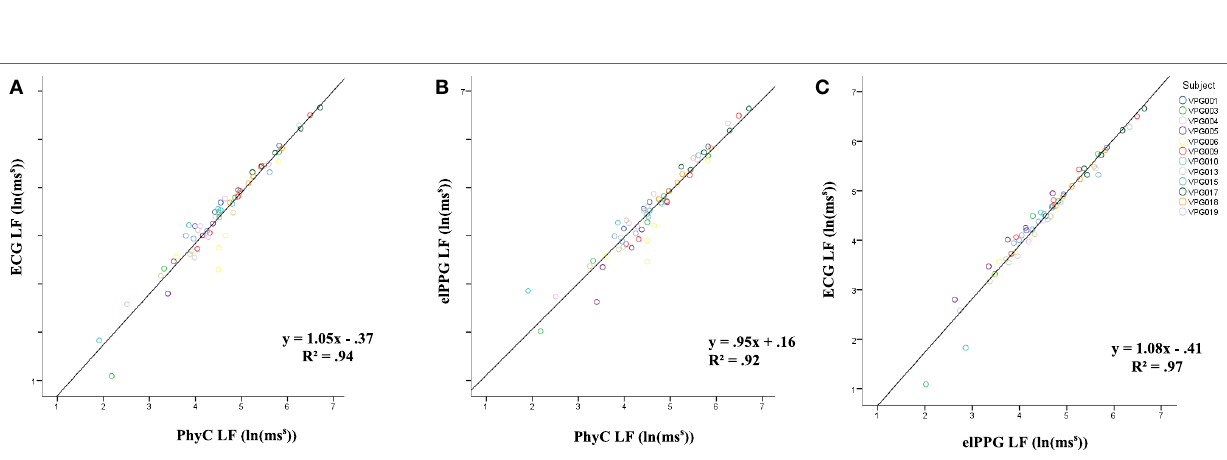
FigUre 8 | Scatter plots between sensors for respiratory sinus arrhythmia (RSA), color coded by participant. (a) PhysioCam (PhyC) vs electrocardiogram (ECG). (B) PhyC vs elPPG. (c) elPPG vs ECG.